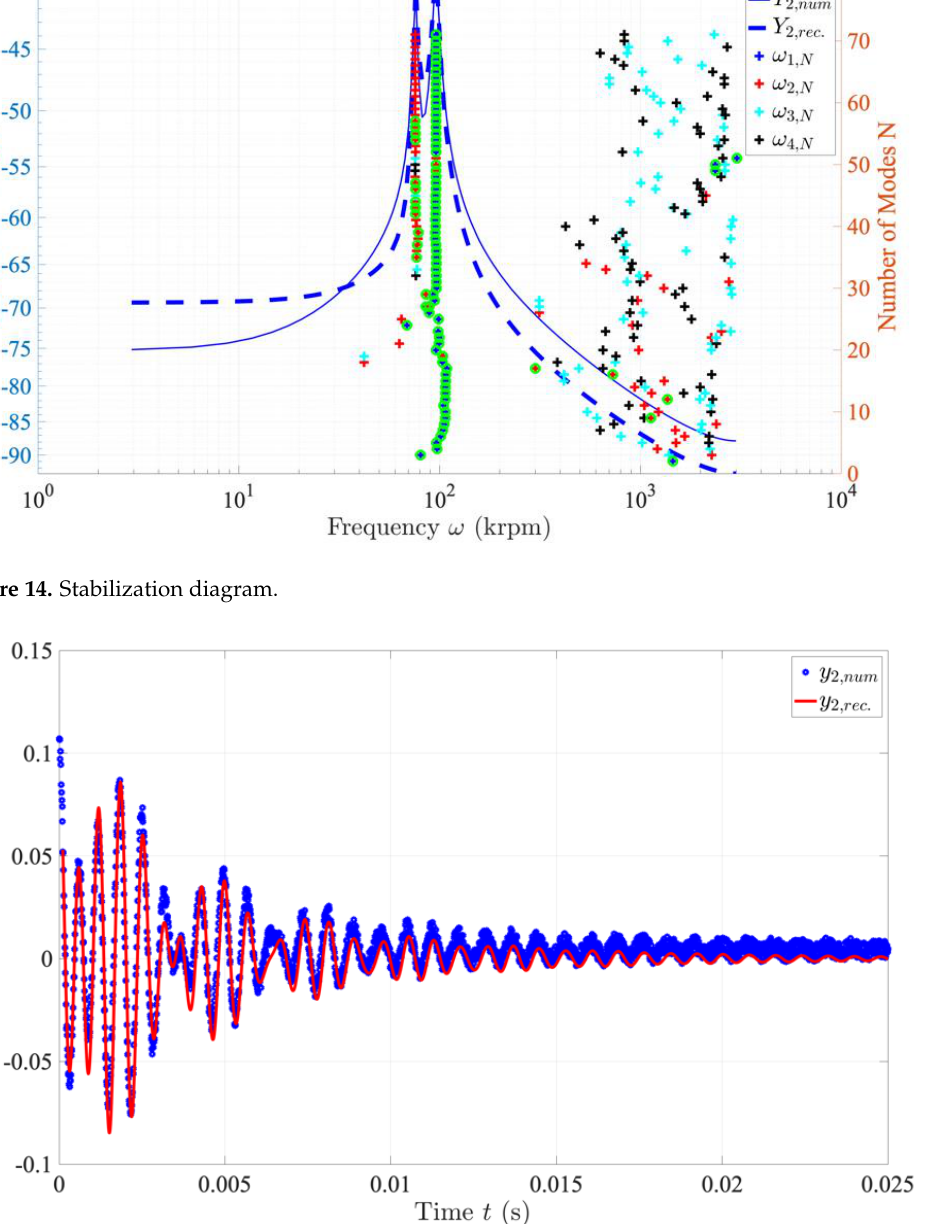
Figure 15. Comparison in time domain of the reconstructed signal with the numerical signal. Table 10. Modal parameters resulting from LSCEM.